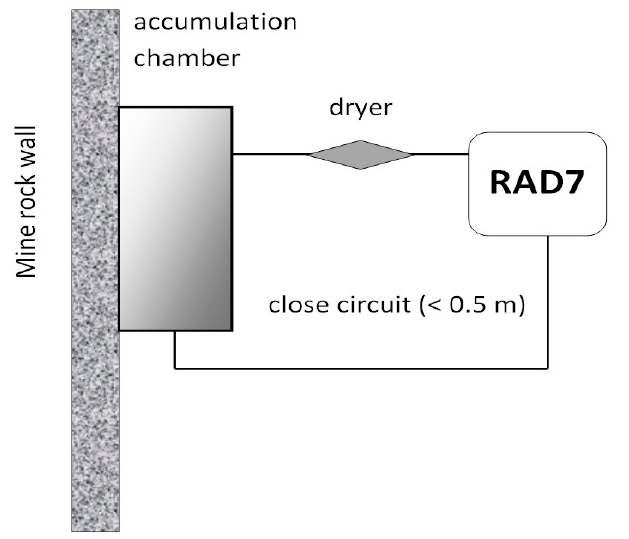
Figure 2. Method of measurement of radon and thoron exhalation from the soil with an application of the accumulation chamber.